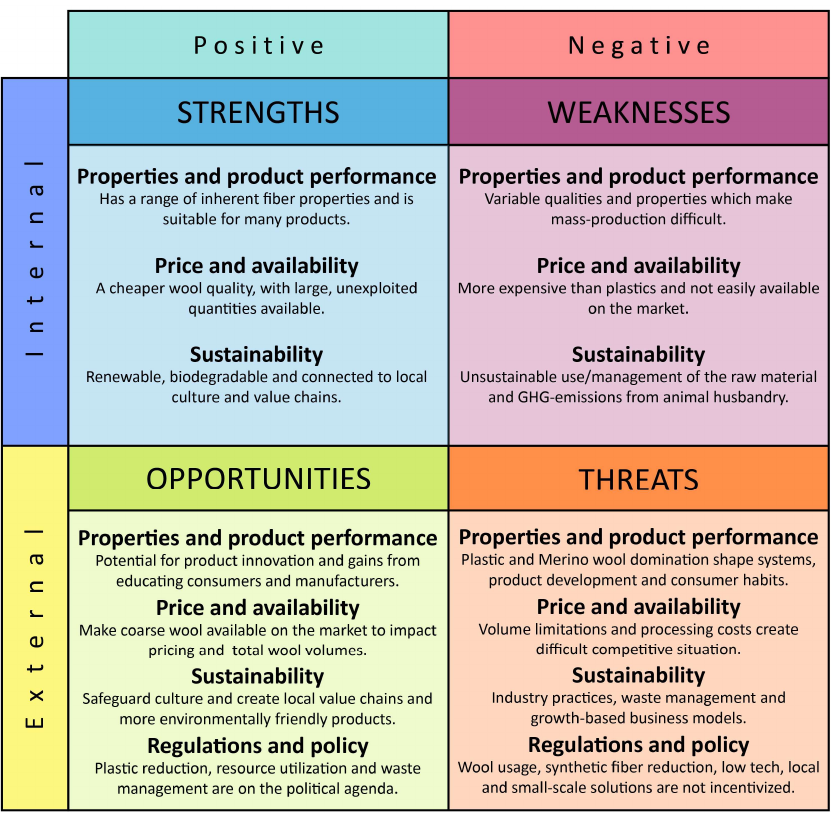
Figure 2. Overview of SWOT analysis of coarse wool.